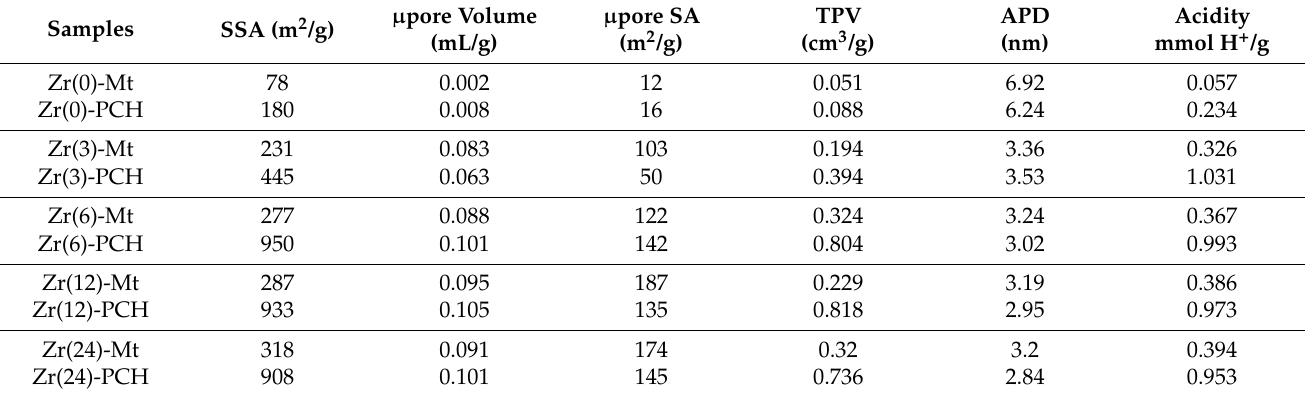
Table 2. Microtextural properties and acidity of Zr(X)-Mt and their Zr(X)-PCH derivatives.